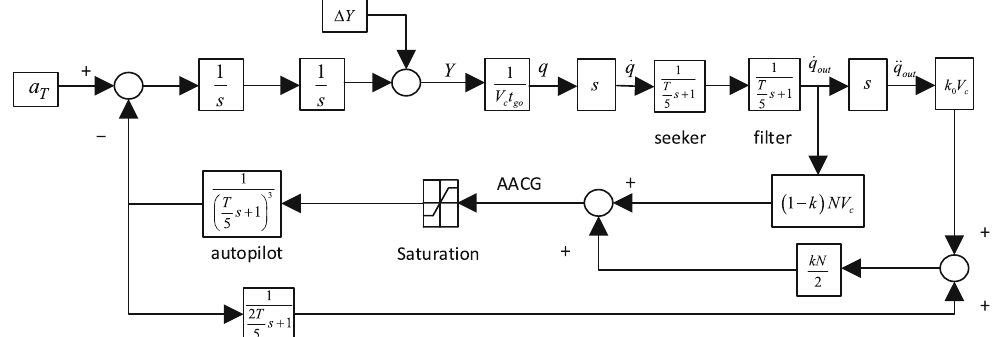
Figure 12: Linearized AACG guidance system.